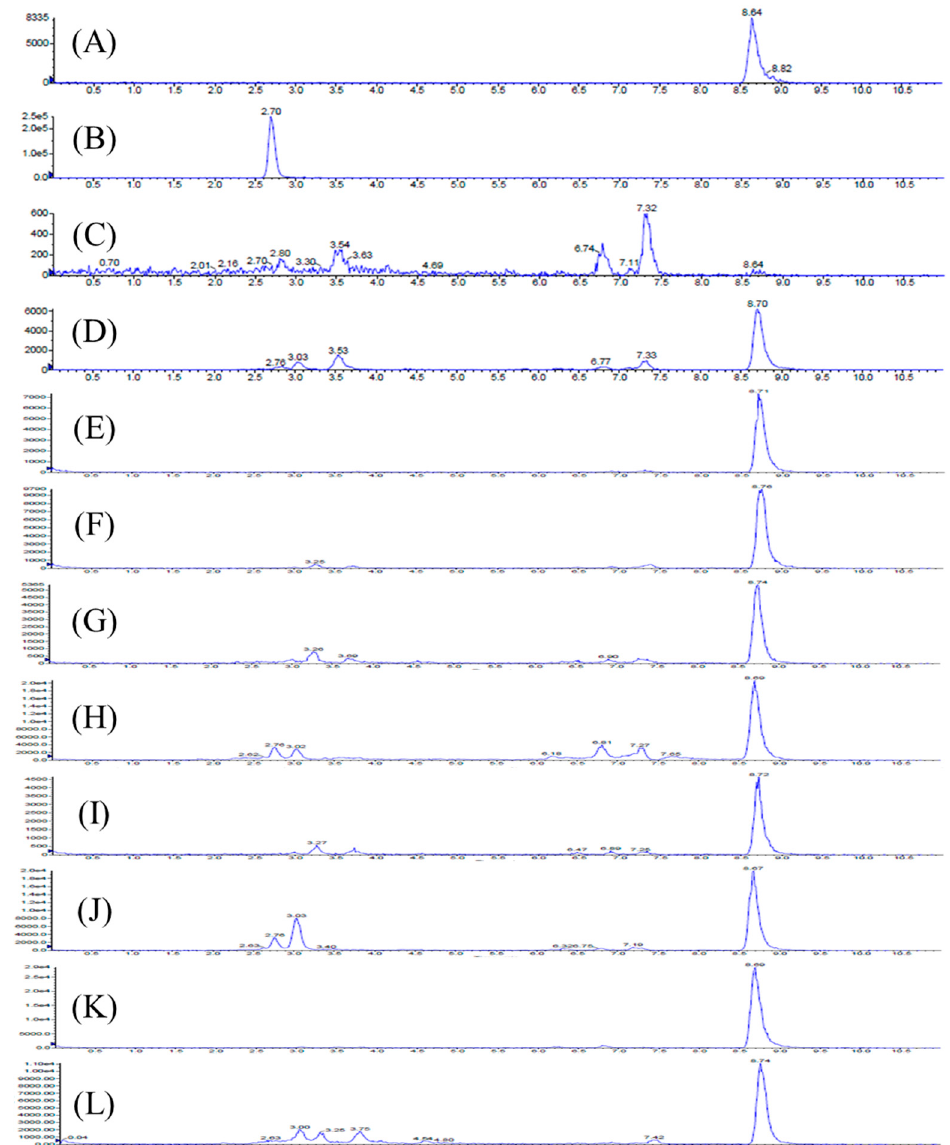
Figure 2. Representative HPLC Chromatograms for ( A ) Erinacine S (100 ng/mL); ( B ) internal standard (4-hydroxybenzaldehyde; 50 ng/mL); ( C ) blank rat plasma; ( D ) rat plasma sample obtained 360 min after a 2.395 g/kg body weight oral dose of Hericium erinaceus mycelia extract (equivalent to 50 mg/kg body weight of Erinacine S); ( E ) brain, ( F ) heart, ( G ) lung, ( H ) liver, ( I ) kidney, ( J ) stomach, ( K ) small intestine, and ( L ) large intestine samples obtained 8 h after a 2.395 g/kg body weight oral dose of the H. erinaceus mycelia extract.